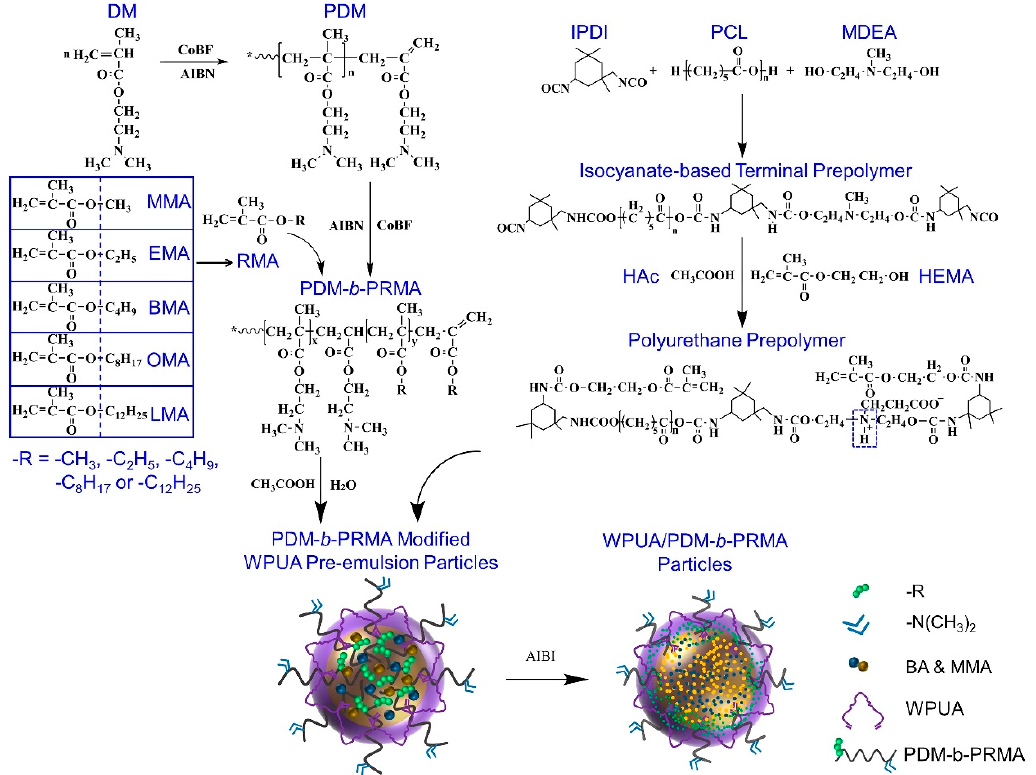
Figure 2. Schematic preparation of PDM- b -PRMA and WPUA / PDM- b -PRMA emulsions.